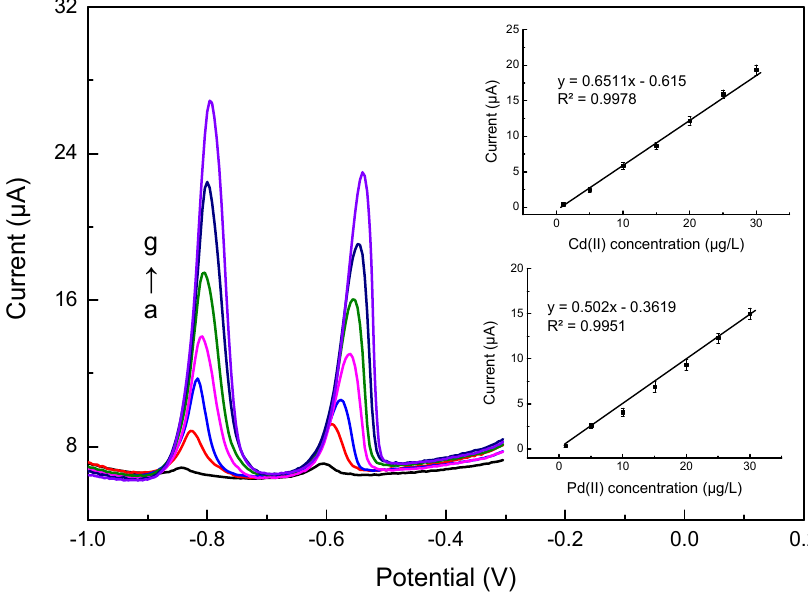
Figure 6. Di ff erential pulse voltammetry of Cd(II) and Pb(II) on the Bi / LC-rGO / DSPE with various concentrations from a to g: 1, 5, 10, 15, 20, 25 and 30 µ g / L. The inset shows the calibration curves for the Figure 6. Differential pulse voltammetry of Cd(II) and Pb(II) on the Bi/LC ‐ rGO/DSPE with various determination of Cd(II) and Pb(II). concentrations from a to g: 1, 5, 10, 15, 20, 25 and 30 μ g/L. The inset shows the calibration curves for the determination of Cd(II) and Pb(II).